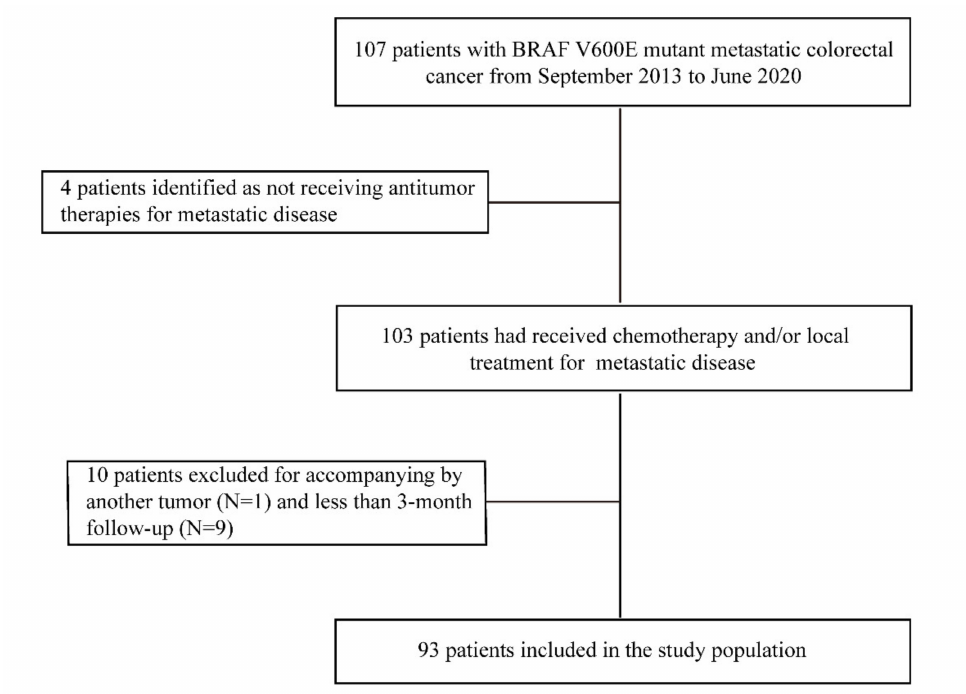
Figure 1. Flow chart of patient selection of this